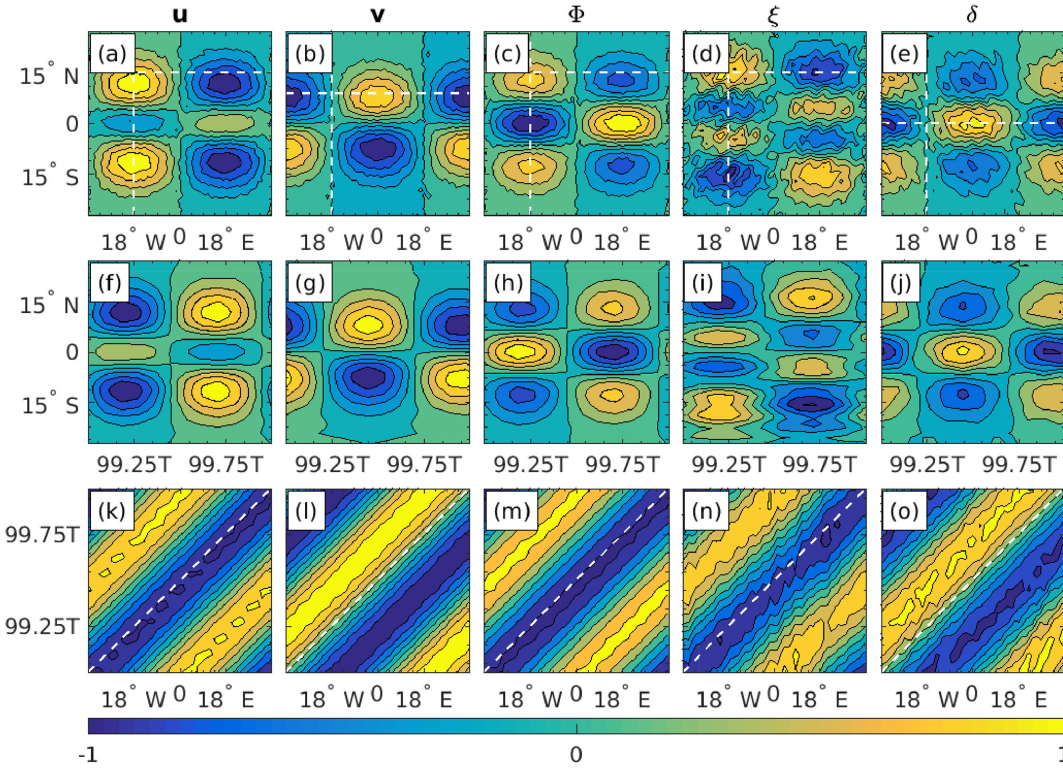
Figure 8. Same as Fig. 5, but for the perturbed EIG wave.